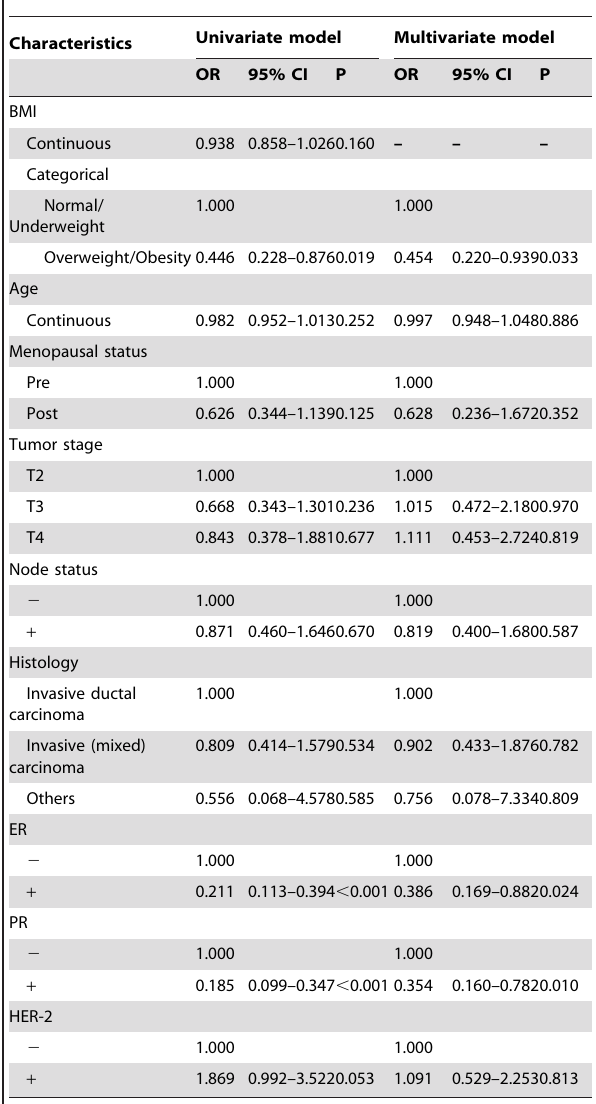
Abbreviations: OR, odds ratio; BMI, body mass index; ER, estrogen receptor; PR, progesterone receptor; HER-2, human epidermal receptor.